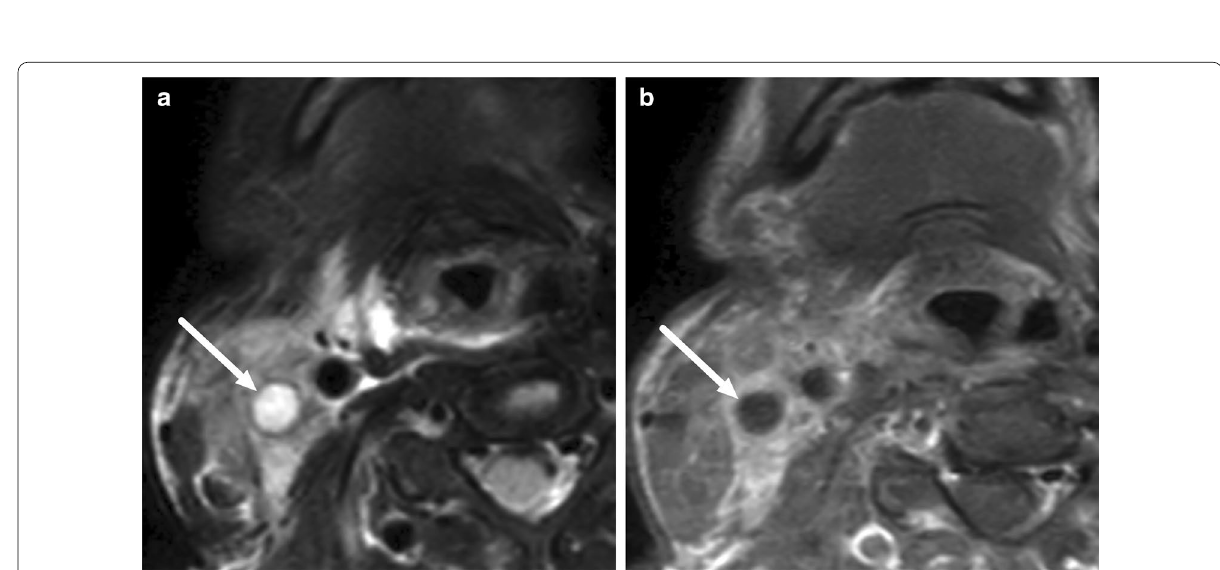
Fig. 27 Thrombosis of the internal jugular vein (arrows) associated with Lemierre’s syndrome in a teenager with a throat infection, demonstrated on axial fat-suppressed T2-weighted ( a ) and post-contrast T1-weighted ( b ) images. Thrombosis may be difficult to detect on standard MRI sequences. Here, the lack of flow void is seen on the T2-weighted image ( a ), whereas the hypointense thrombus is difficult to separate from the flow void on the T1-weighted image ( b